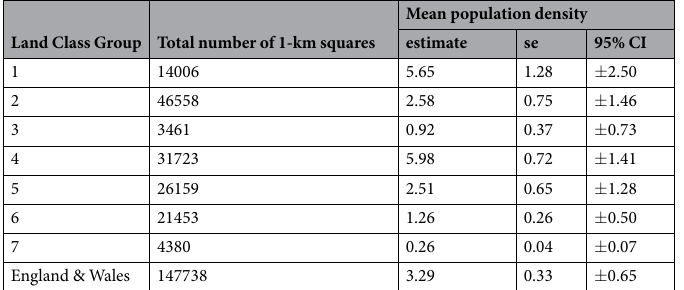
Table 3. Estimates of mean badger population density in each Land Class Group with standard error and 95% confidence